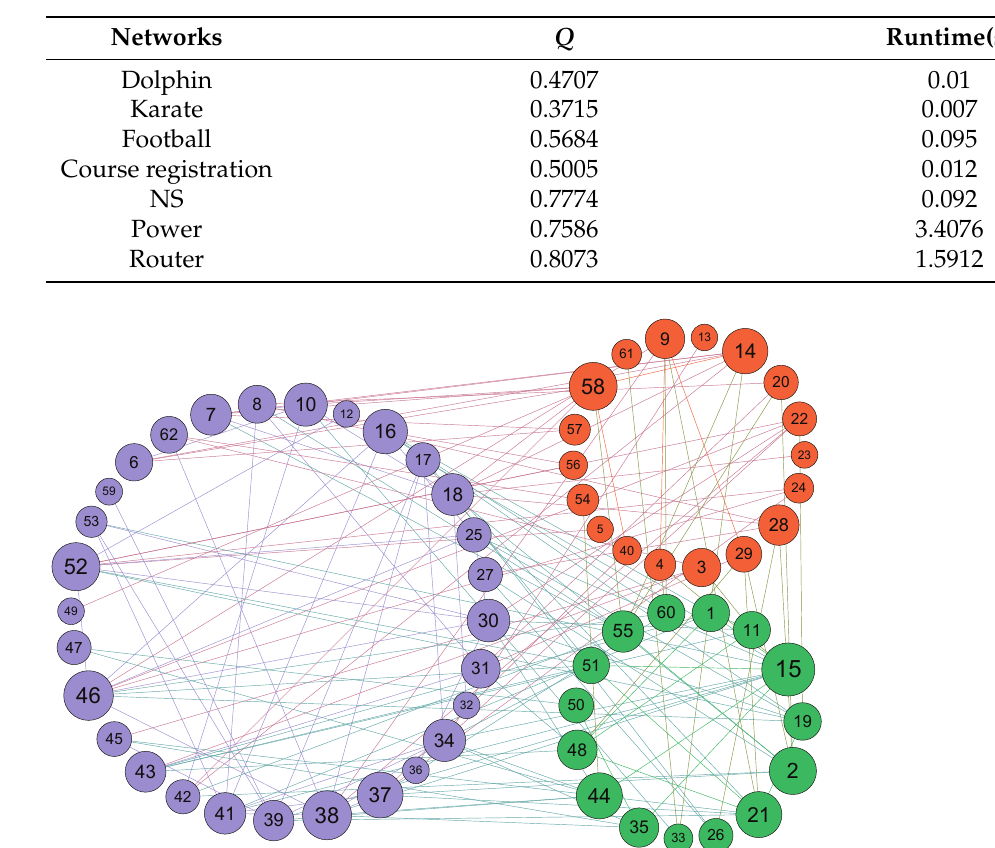
Table 5. The experimental results derived from performing NINS on real networks.